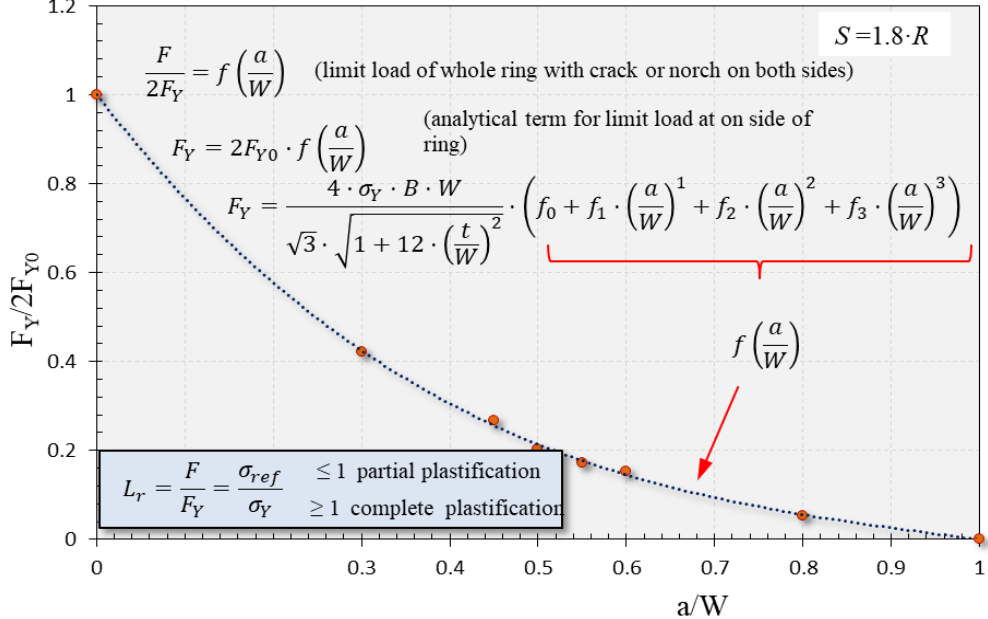
Figure 11. The limit load function for R / B = 8 and W / B = 2 in dependence on different crack aspect ratios a / W from 0.3 to 0.8.